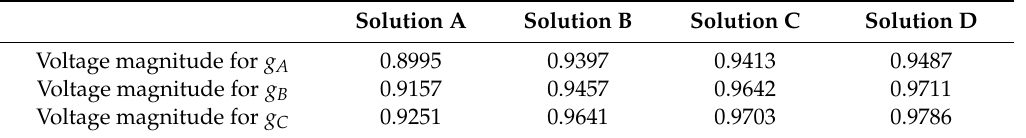
Figure 8. Node voltages of solution D for all tap position constraints ( g A – g C ). ( a ) Node voltages (equality constraint of g A ); ( b ) node voltages (equality constraint of g B ); ( c ) node voltages (equality constraint of g C ).